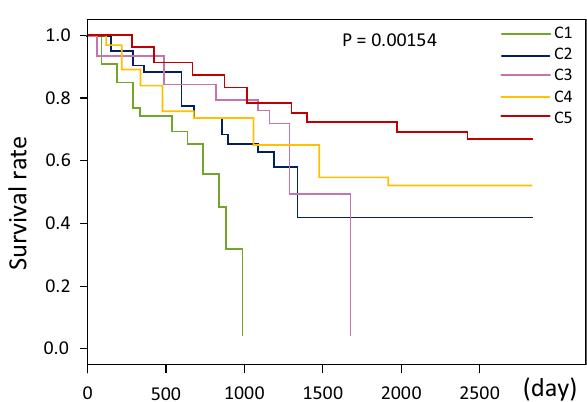
Figure 10. Kaplan–Meier survival curves for five lung cancer subtypes.